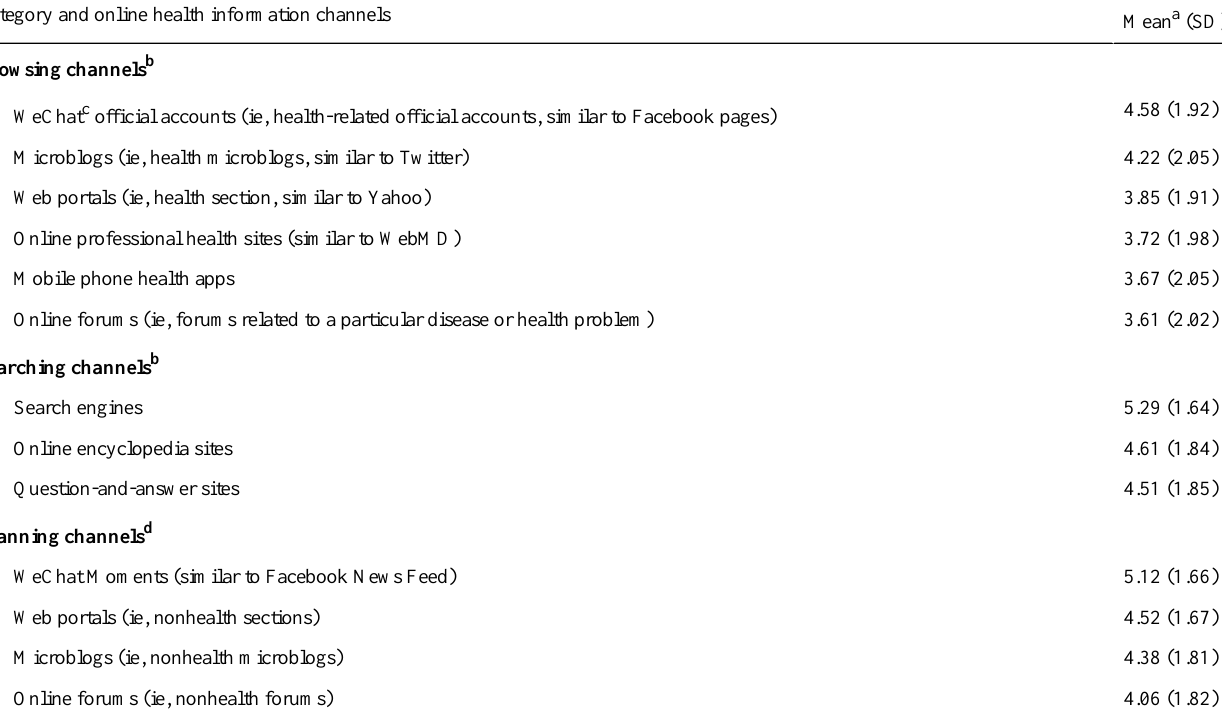
tasks other than health information search?” [9]. As shown in Table 1, search engines (active) and WeChat Moments (incidental exposure, similar to Facebook News Feed) were the 2 most frequently used channels (search engines: mean 5.29, forums and mobile health apps were the 2 least used channels SD 2.05).